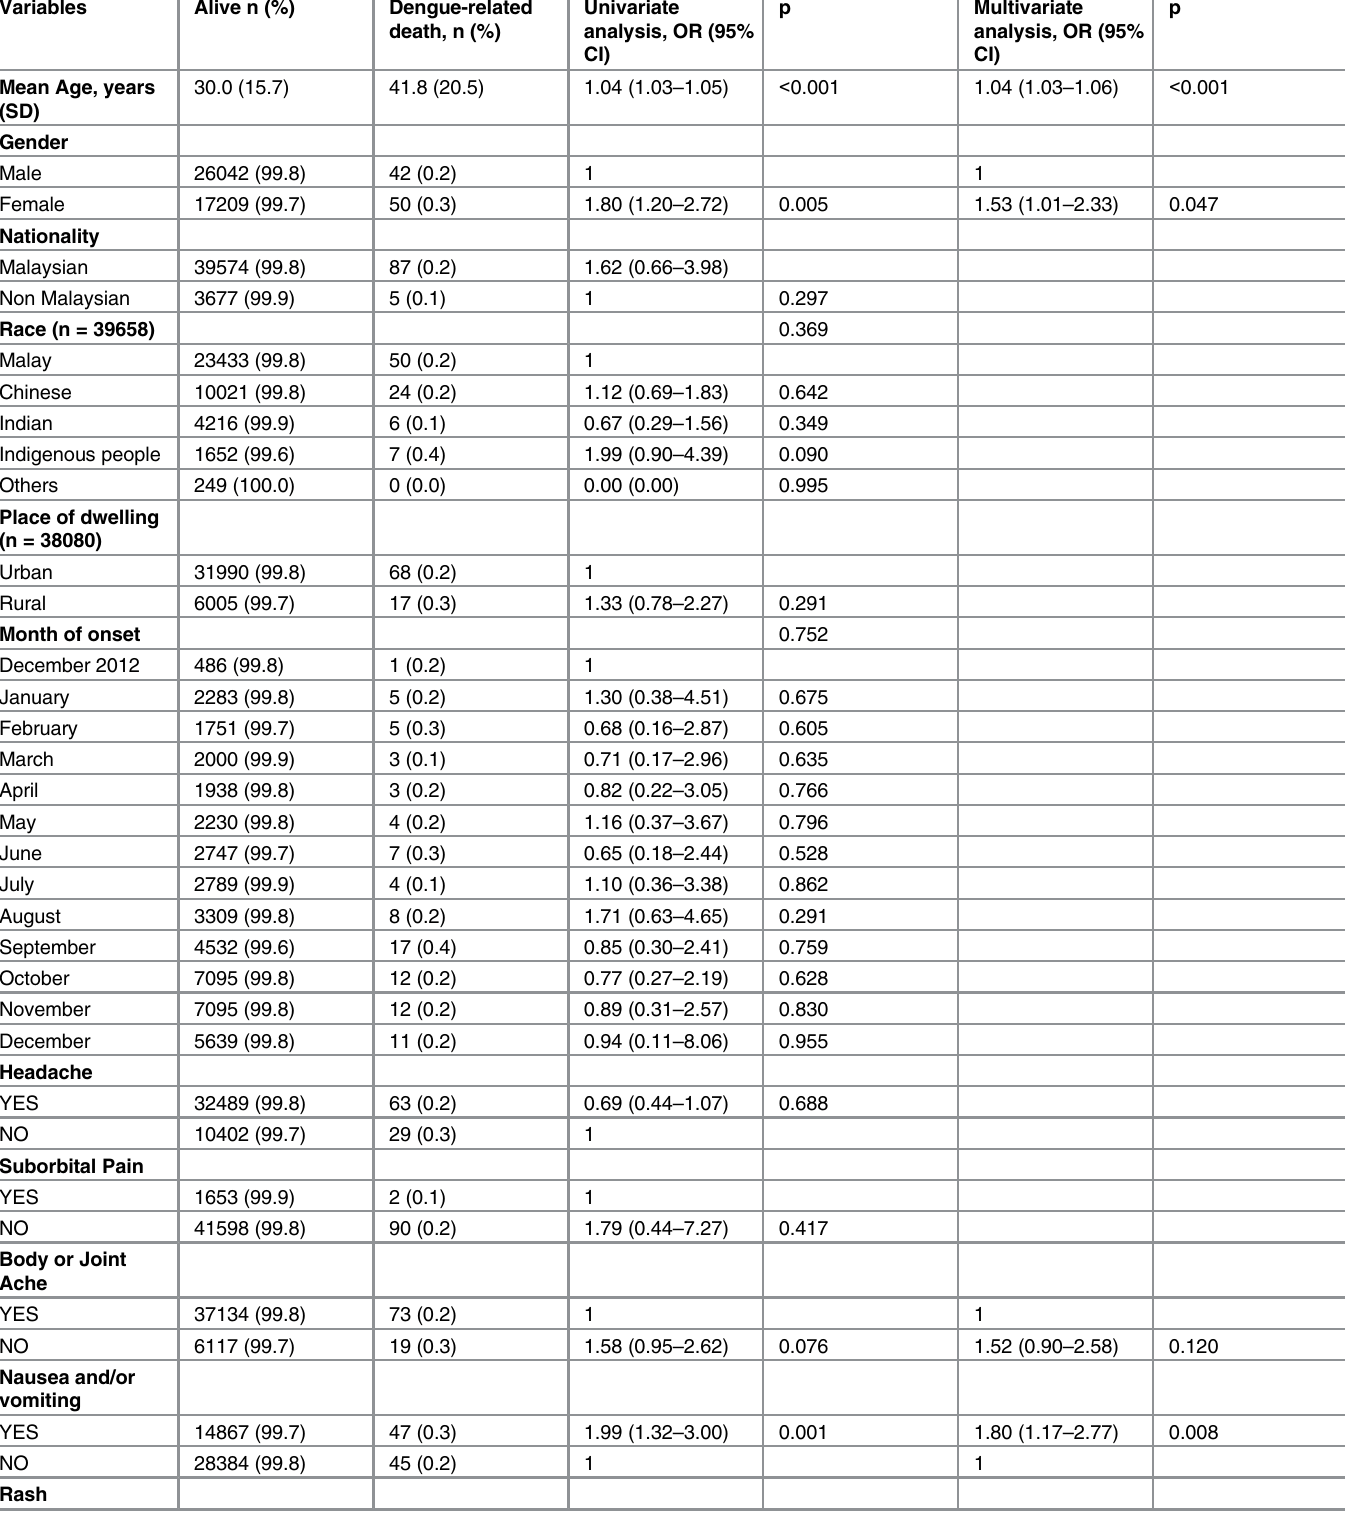
Table 4. Univariate and multivariate analysis (n = 43343) of probable dengue-related mortality.